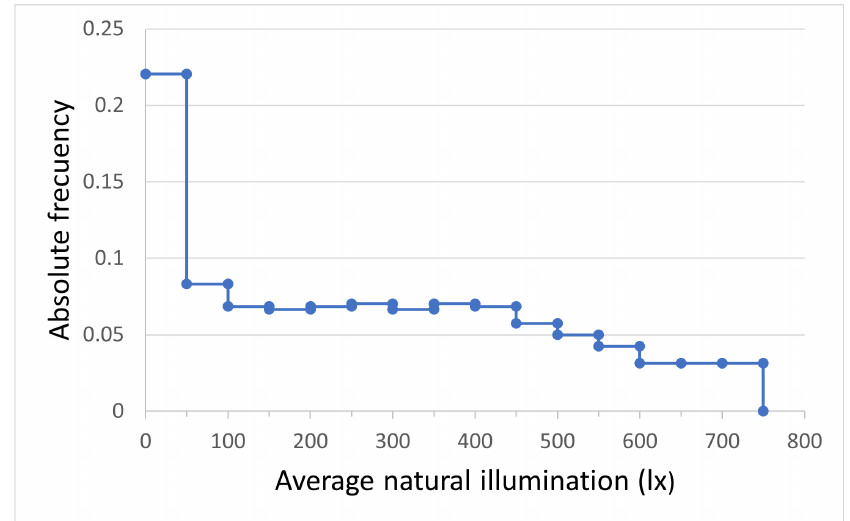
Figure 18. Histogram of average lighting levels inside the classroom with heliostatic illuminators during their time of use for teaching purposes in a full year.